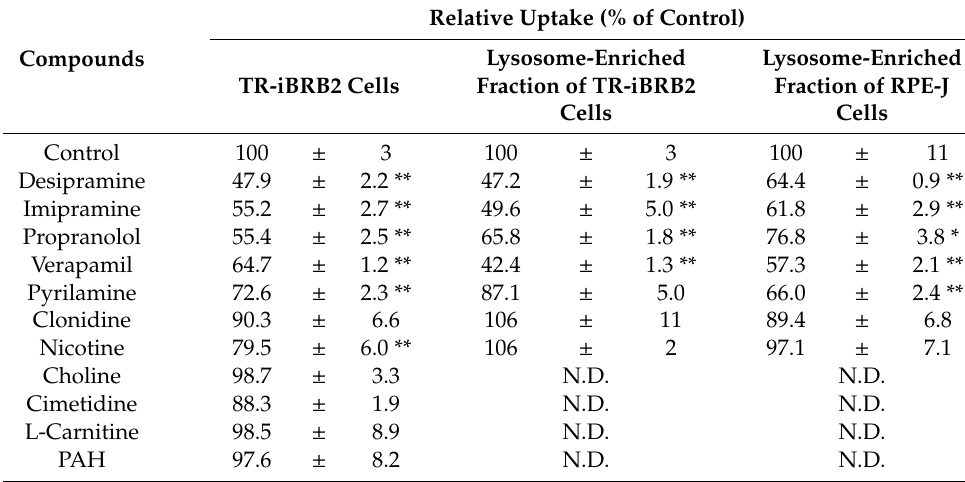
Table 1. Inhibitory Effect of Quinacrine Uptake.